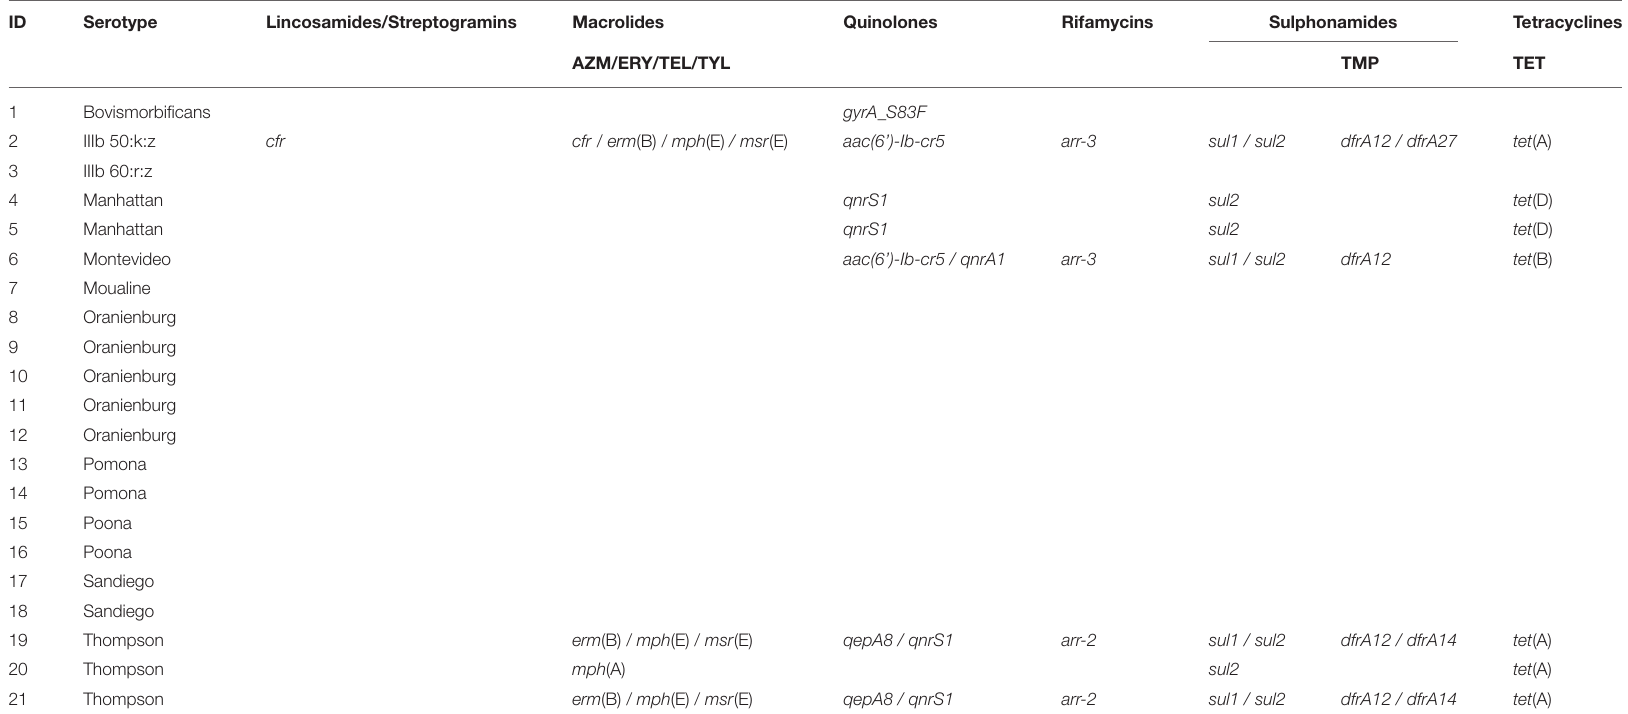
TABLE 4b | Antimicrobial resistance genes identified in Salmonella enterica isolates from